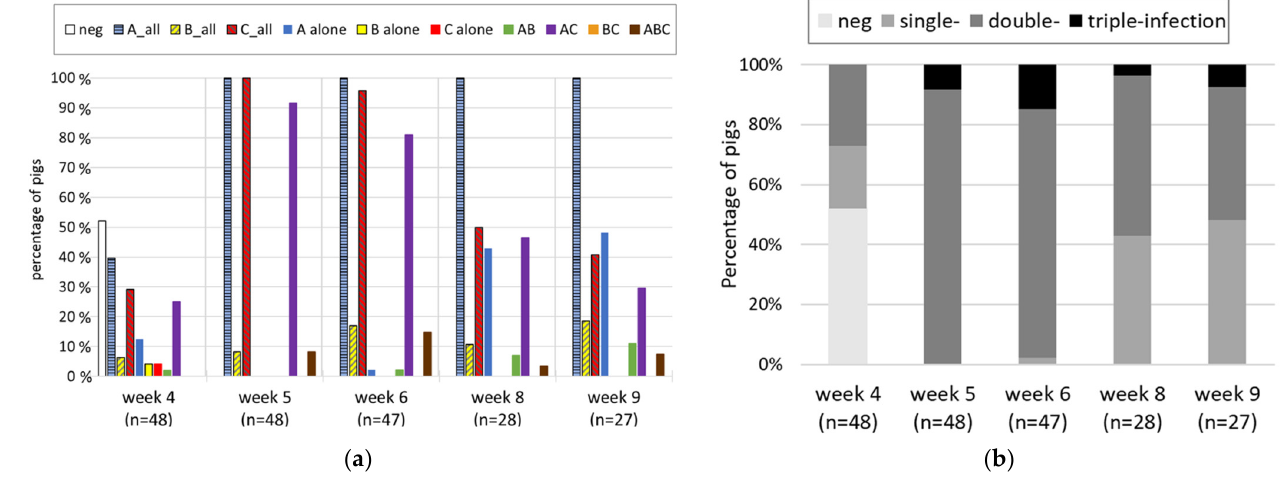
Figure 3. The percentage of pigs from the longitudinal study with ( a ) different types of RV (co-) infections and ( b ) different numbers of (co-)infecting RV species are shown, grouped by the sam- pling week (=week after birth). The piglets were weaned in week 4. The “_all” indicates that all samples positive for this RV species are included in this group (=overall result), independent of co- infecting